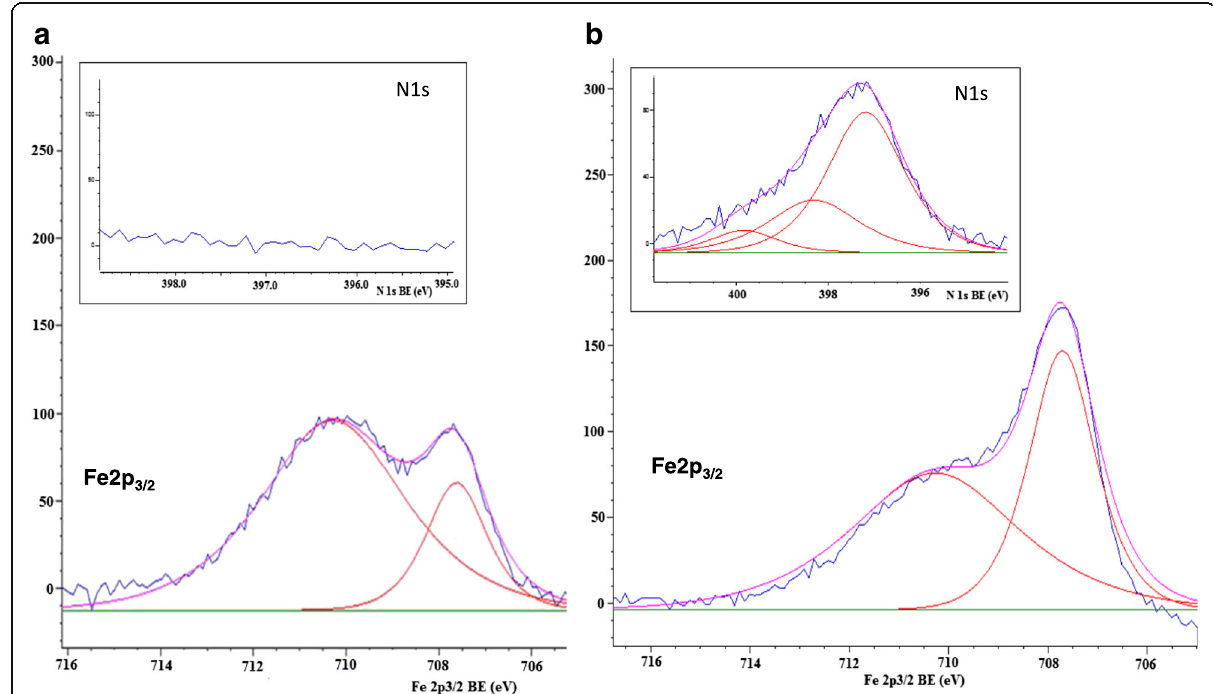
Fig. 7 Deconvoluted XPS Fe2p 3/2 spectra of Fe x Ti y O z 450 ( a ) and N/Fe x Ti y O z 450 ( b ) films. Inset : XPS N1s